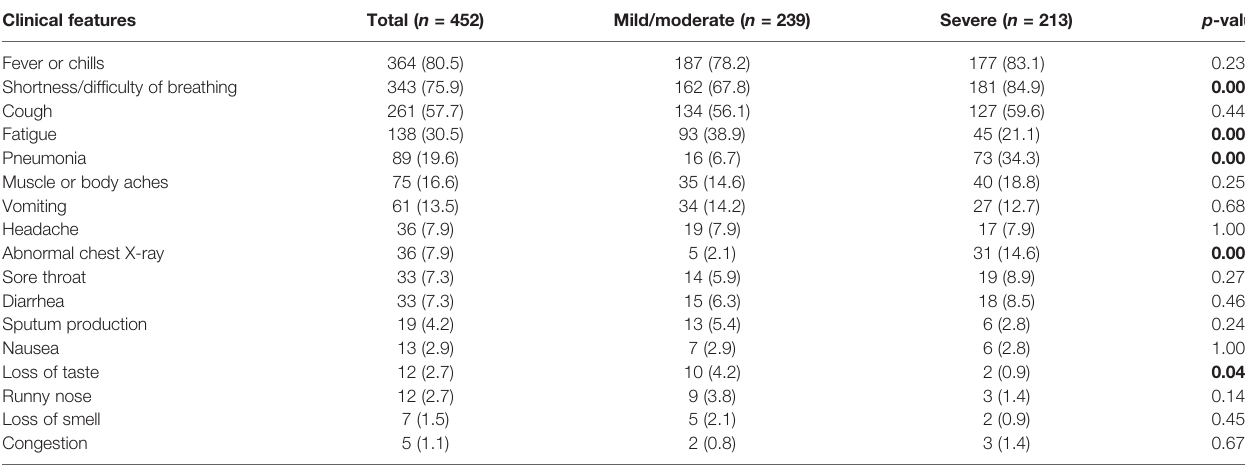
TABLE 2 | Clinical features of 452 symptomatic COVID-19